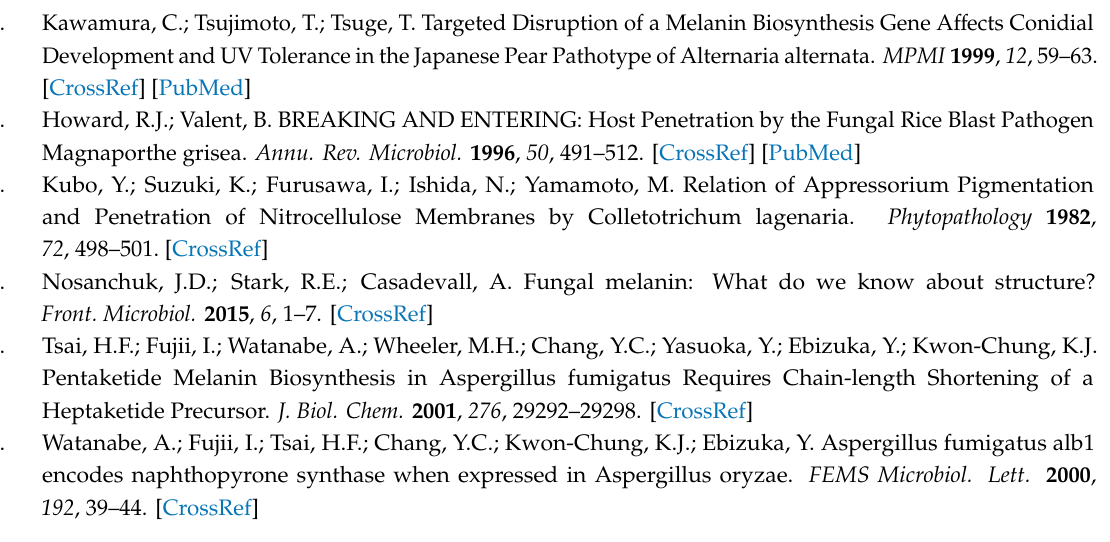
Figure S1. Construction of disruption plasmid, pTAR-Hyg-0 from pATMT-GpdGFP, Figure S2. Construction of plasmid used in the targeted gene replacement of AlSCD1 in Al Kewell, Figure S3. Integration and coverage of hph-cassette in Al Kewell JD202.9, Figure S4. Integration and coverage of hph-cassette in Al Kewell JD202.22, Figure S5. Colony morphology of Al Kewell WT and transformants, Figure S6. Tricyclazole inhibition of Al Kewell WT and transformants, Figure S7. Appearance of Al Kewell WT and transformants on the surface of ILL6002 14 days post infection, Table S1. List of SCD orthologs from other fungal organisms, Table S2. Summary of genome assembly statistics for Nanopore sequencing of Al Kewell WT and